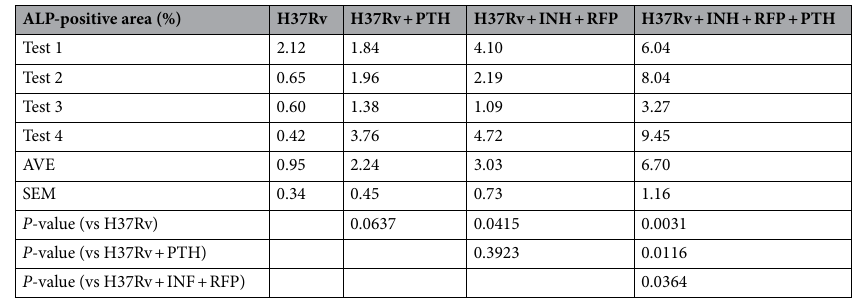
Table 2. Alkaline phosphatase (ALP) staining